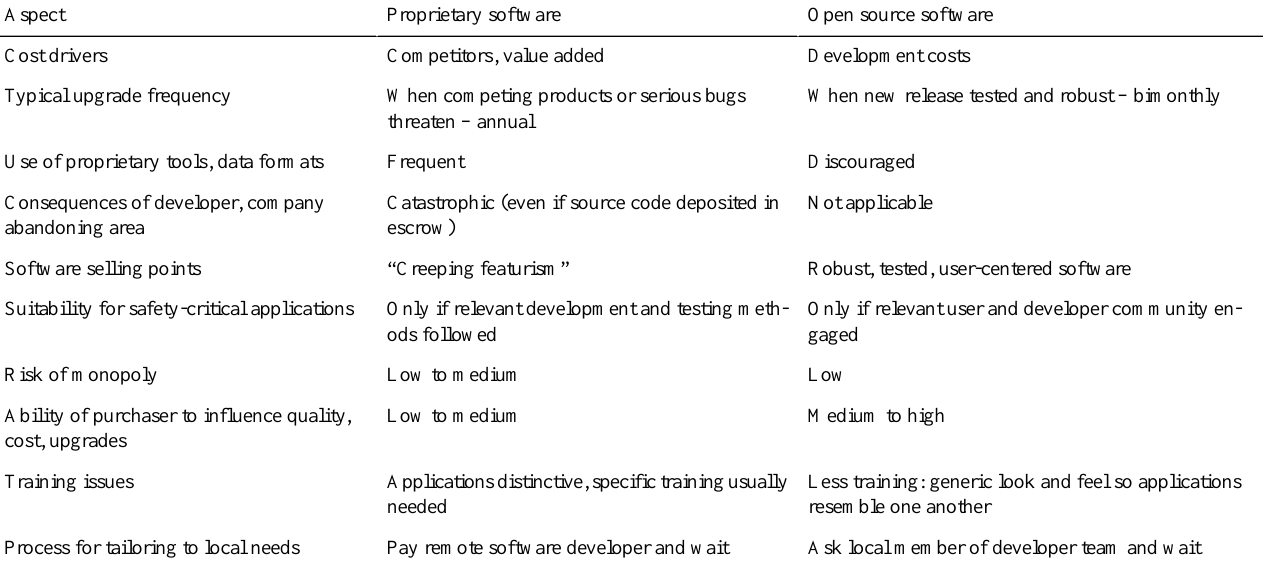
Table 2. Implications of the differences in proprietary and open source software development methods